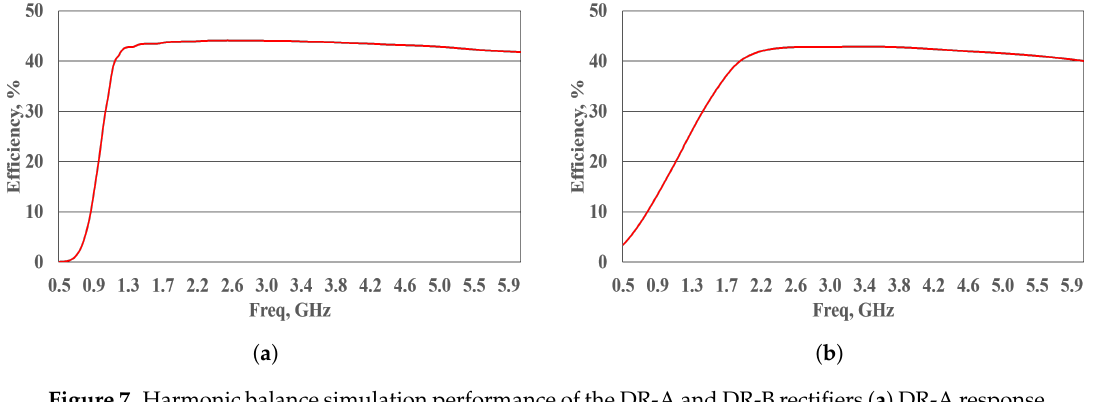
Figure 7. Harmonic balance simulation performance of the DR-A and DR-B rectifiers ( a ) DR-A response, ( b ) DR-B response. Both simulations were conducted at P in = 9 dBm and R L = 1 k Ω . Table 2. List of the DR-A and DR-B parameters.